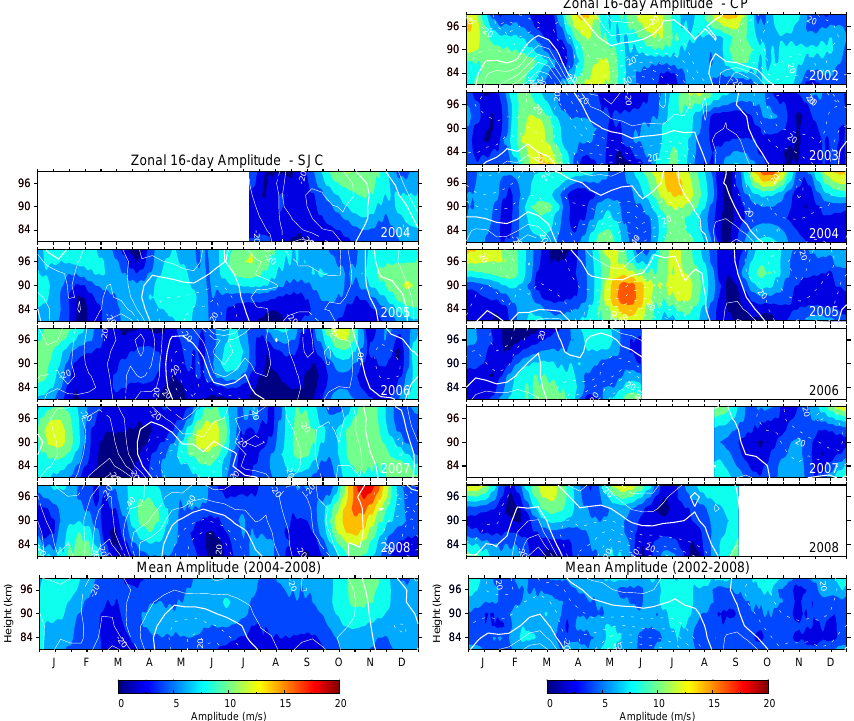
Figure 10. The time-height cross section of the 16 day oscillation amplitudes and composite-year 16 day amplitudes at Cariri (left hand plots) and over C. Paulista (right hand plots) for zonal component, for the years 2004 to 2008 and 2002 to 2008, respectively. Monthly mean eastward (dotted) and westward (solid) winds also are plotted as open white contours. may have been caused by some instability process in situ.